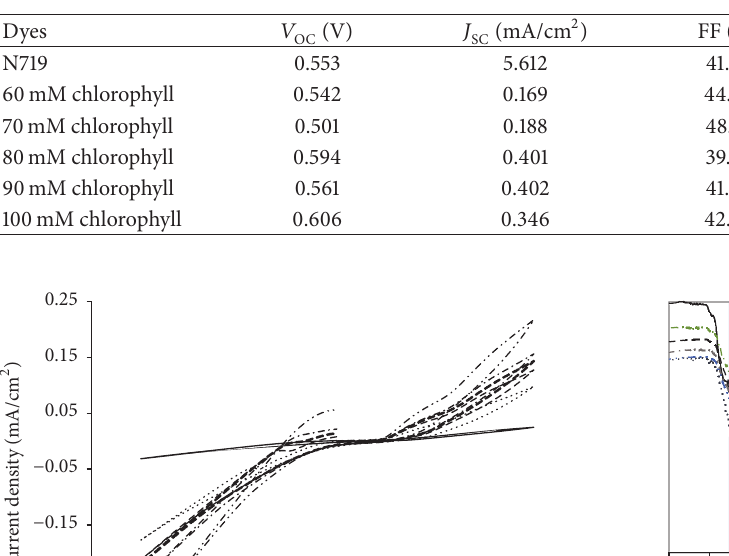
Table 2: Characteristics of DSSCs based on N719 and chlorophyll dyes.